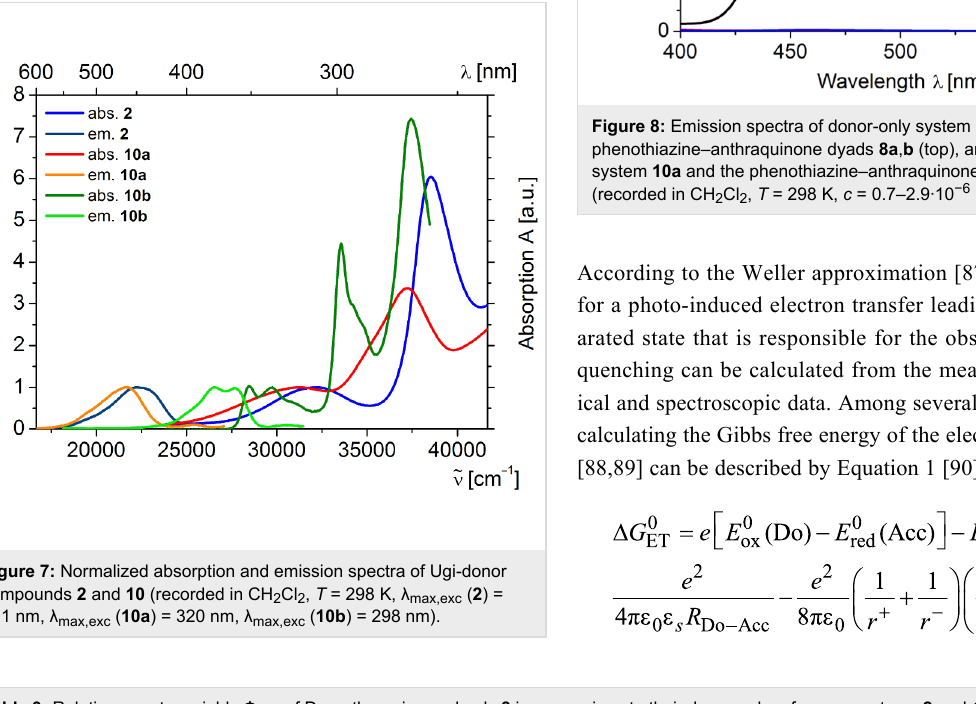
Table 3: Relative quantum yields Φ f,rel of Do-anthraquinone dyads 8 in comparison to their donor-only reference systems 2 and 10 . Donor-only reference